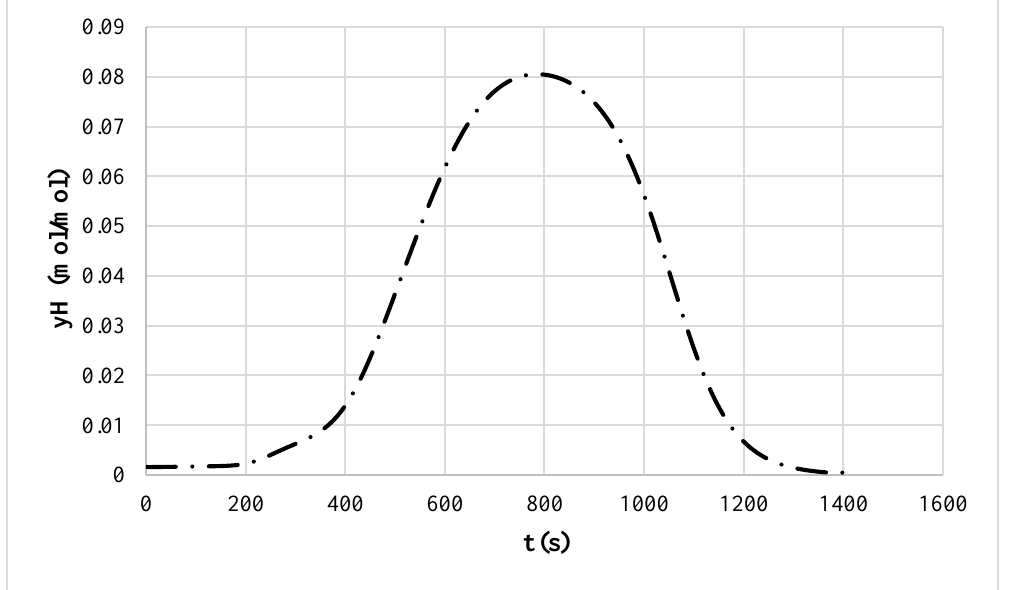
Figure 18. Hexane regeneration with